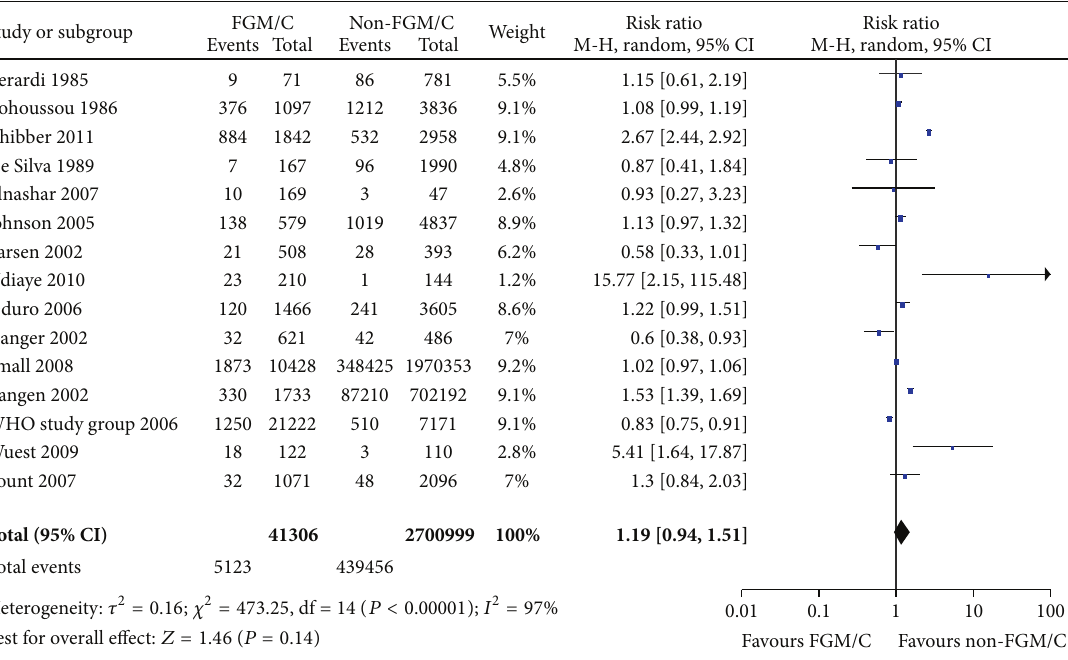
Figure 4: Forest plot, cesarean section. Note: Sensitivity analyses for study type were not statistically